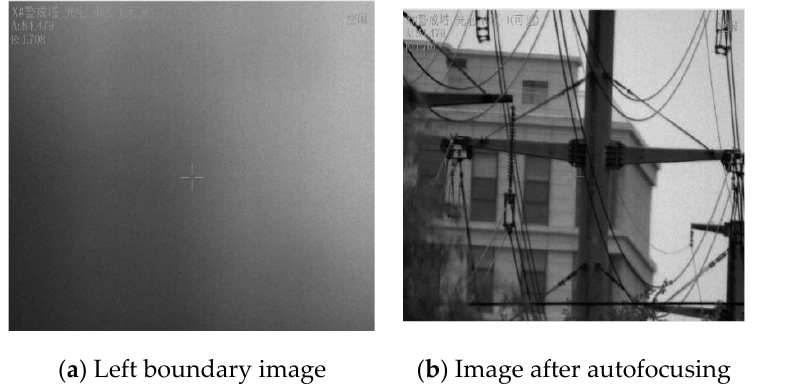
Figure 20. Left boundary autofocusing process.